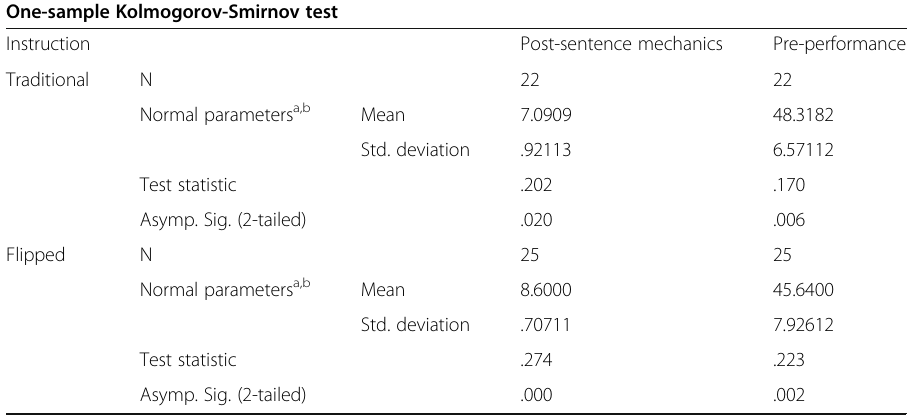
Table 12 Normality test (post-sentence mechanics and pre-performance) One-sample Kolmogorov-Smirnov test